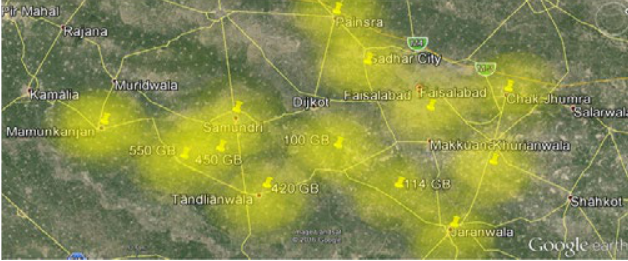
Figure 5. Yellow circles depicts zones of 10 Km radius that were generated using Google earth